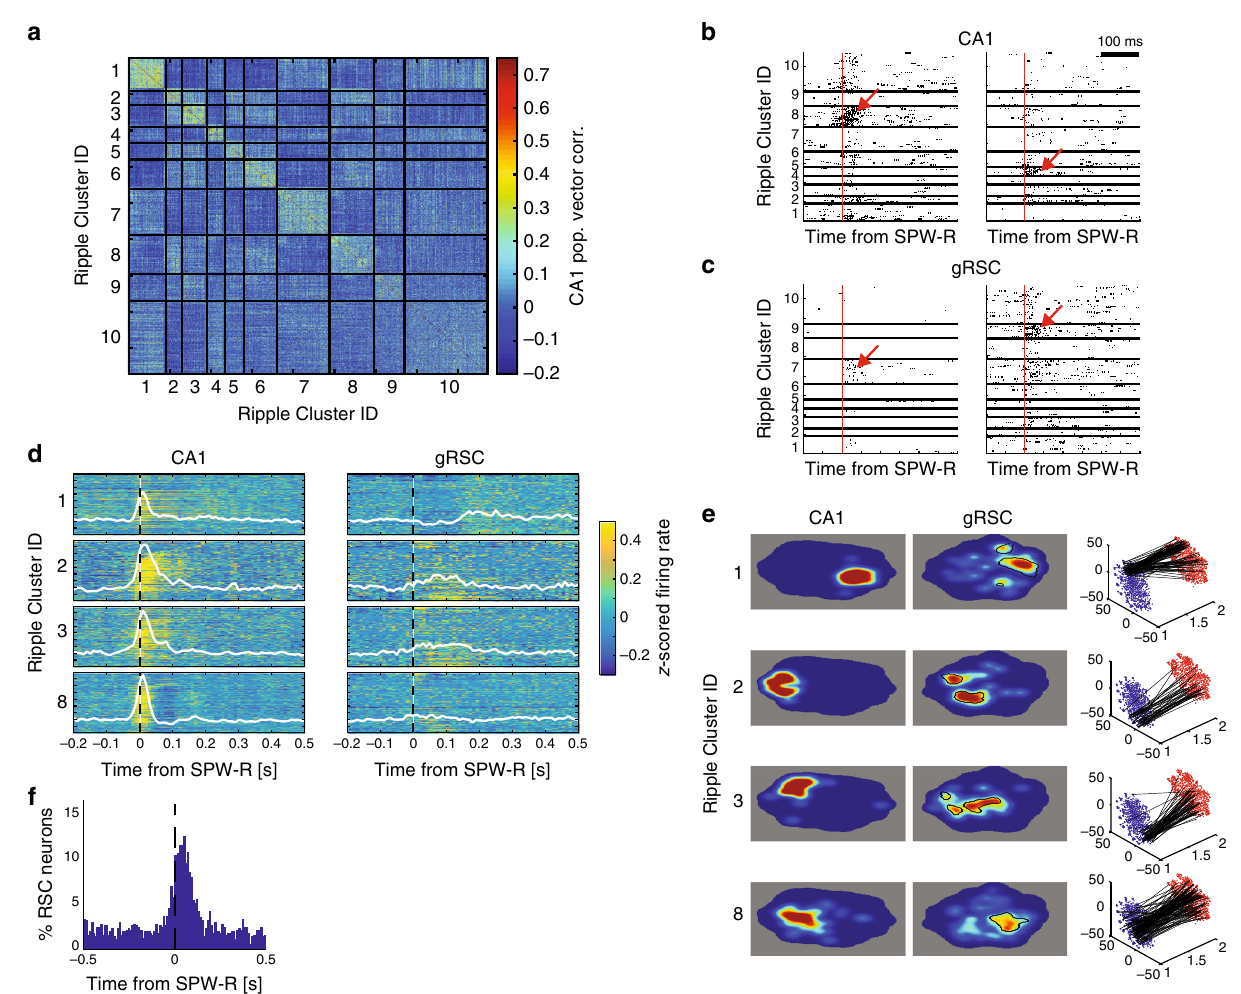
Fig. 5 Retrosplenial activity distinguishes CA1 ripple fi ring patterns. a Example similarity matrix showing the correlation of population fi ring rate vectors of CA1 ensembles during ripples. Matrix sorted by ripple cluster labels ( N = 871 ripples). b Two example CA1 neuron responses to different ripple types (red arrows). Red line, ripple onset. c As in ( b ) for two example gRSC neurons. d Population responses to four classes of ripple. Each row of each panel shows the normalized fi ring rate of an individual neuron around ripple onset, averaged across all ripples of the same type. White line, population average. e Two-dimensional histograms of the t-SNE representation for each ripple cluster type shown in d for CA1 (left), gRSC (middle), and their event-by-event correspondence (right, black lines). Black contours in the gRSC denote the region of t-SNE space with higher density than expected by chance ( p < 0.01, permutation test with 1000 shuf fl es; see Methods). See Supplementary Fig. 6 for additional examples. f Percentage of retrosplenial neurons